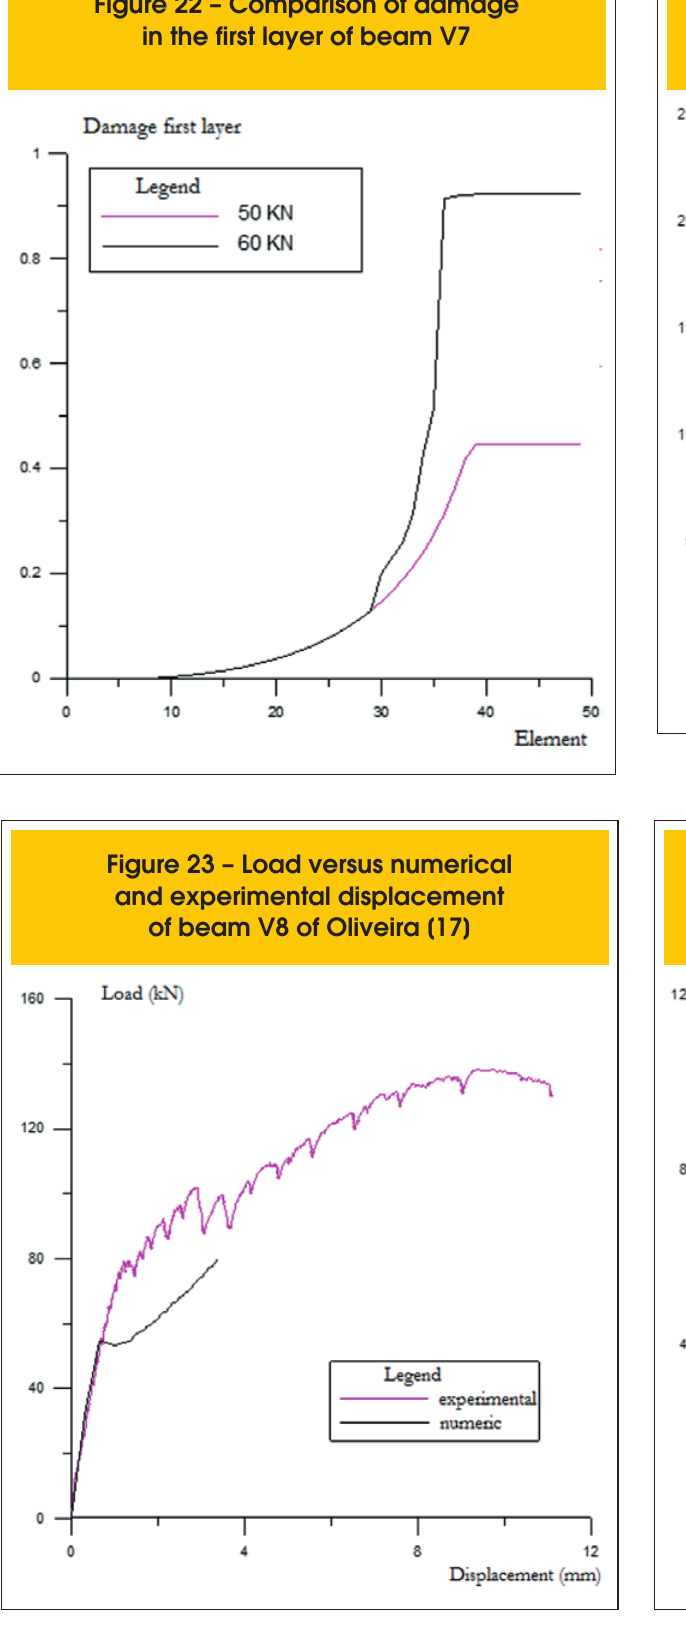
Figure 24 – Load versus numerical and